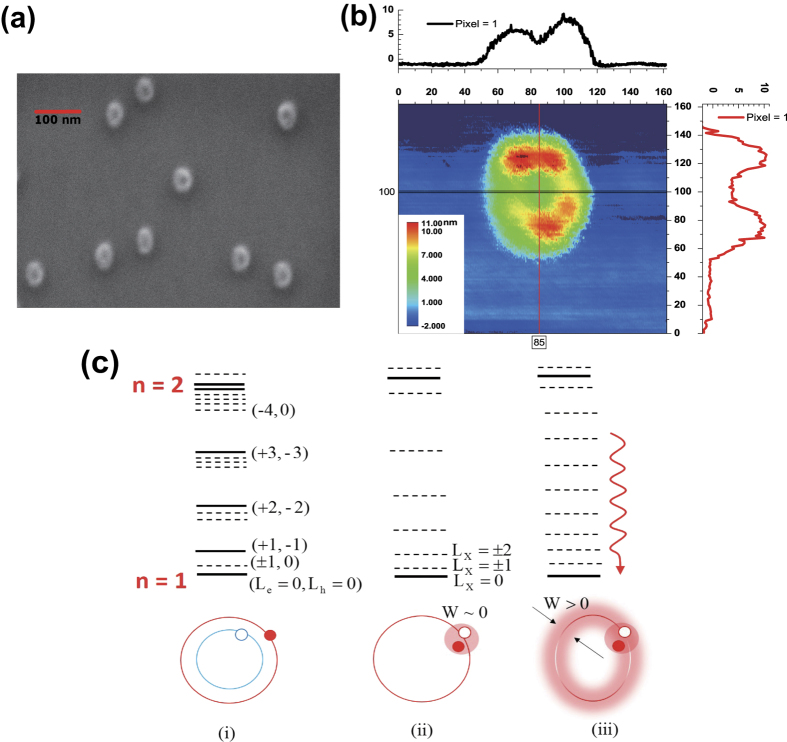
Quantum ring structures observed by FESEM (a) an AFM image of a single QR shows rim height anisotropy and lateral shape asymmetry (b). (c) Energy levels of an electron-hole pair in a QR are shown schematically. (i) When both the ring width (W) and the Coulomb interaction are ignored, the various levels of an independent electron and a hole are specified by two angular momenta (Le, Lh) of the one-dimensional orbits (Re, Rh). (ii) When the Coulomb interaction is considered, the single particle states of the center-of-mass exciton are described by the total angular momentum LX for the widthless orbit (RX). (iii) The finely-spaced levels become modified in the presence of a finite ring width (W > 0), rim height anisotropy, and lateral shape asymmetry.